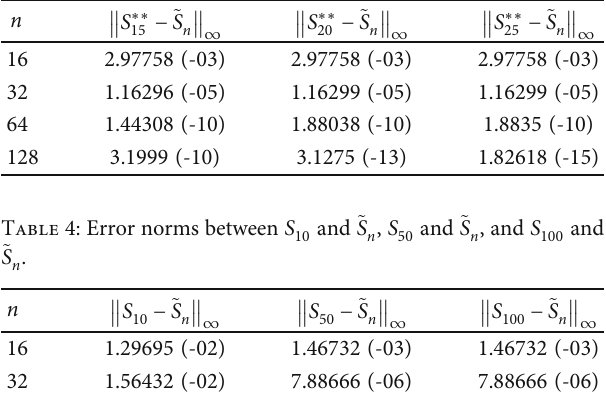
Table 3: Error norms between S ∗∗ ~ . S n